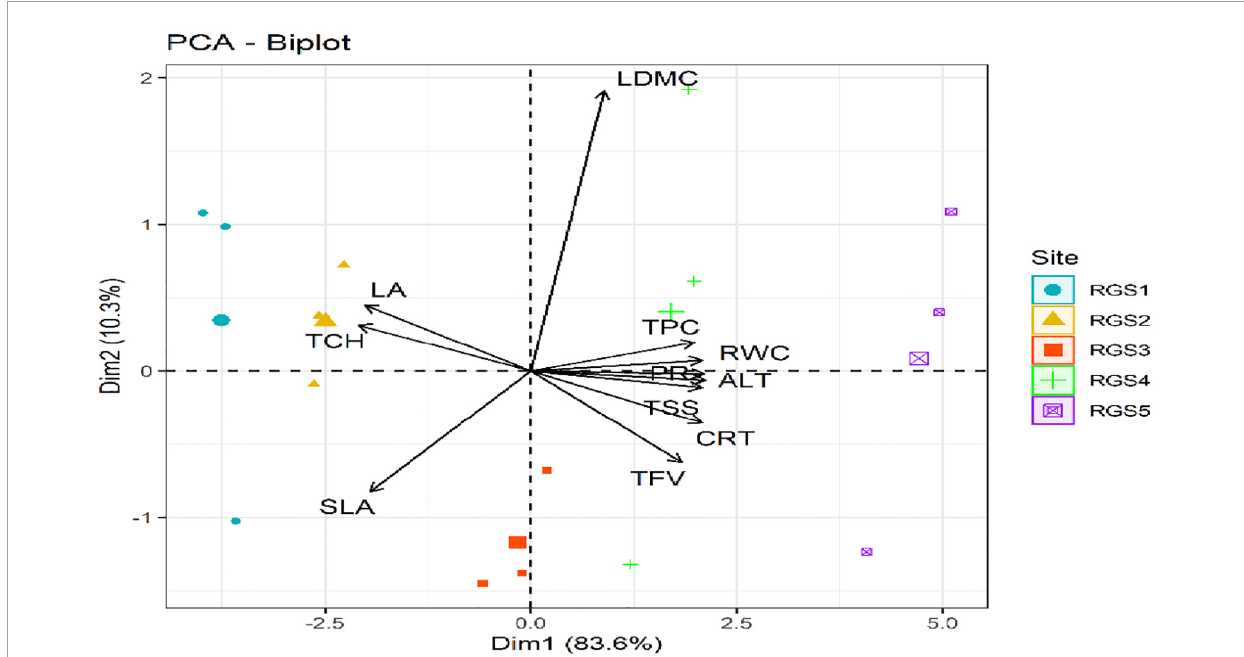
FIGURE6 Principal component analysis (PCA) biplot of Rhododendron anthopogon eco-physiological traits across the five sampling sites: Site-1 (RGS1), Site-2 (RGS2), Site-3 (RGS3), Site-4 (RGS4), and Site-5 (RGS5) along an altitudinal gradient in the Gulmarg area of Kashmir Himalaya. RWC, relative water content; LDMC, leaf dry mass content; LA, leaf area; SLA, specific leaf area; PR, proline content; TCH, total chlorophyll; CRT, carotenoid content; TPC, total phenolics content; TFV, total flavonoids; TSS, total soluble sugars; ALT, altitude.